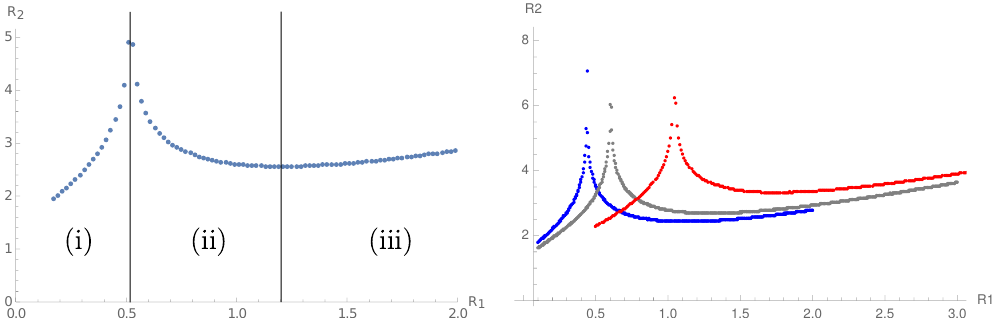
Figure 9 . The left panel shows the behaviour of the outer radius as inner radius varies, and the three di(cid:11)erent regions. Note that there are two critical points on this graph and the \squashing" of loops takes place both in region (ii) and (iii). The right panel shows the behaviour for di(cid:11)erent masses m q = f 0 : 8 ; 1 : 0 ; 1 : 5 g (blue, gray, red) and (cid:12)xed mass of the outer quarks m Q = 9 : 5. more squashed , see the middle panel in (cid:12)gure 8. Note that while the squashing